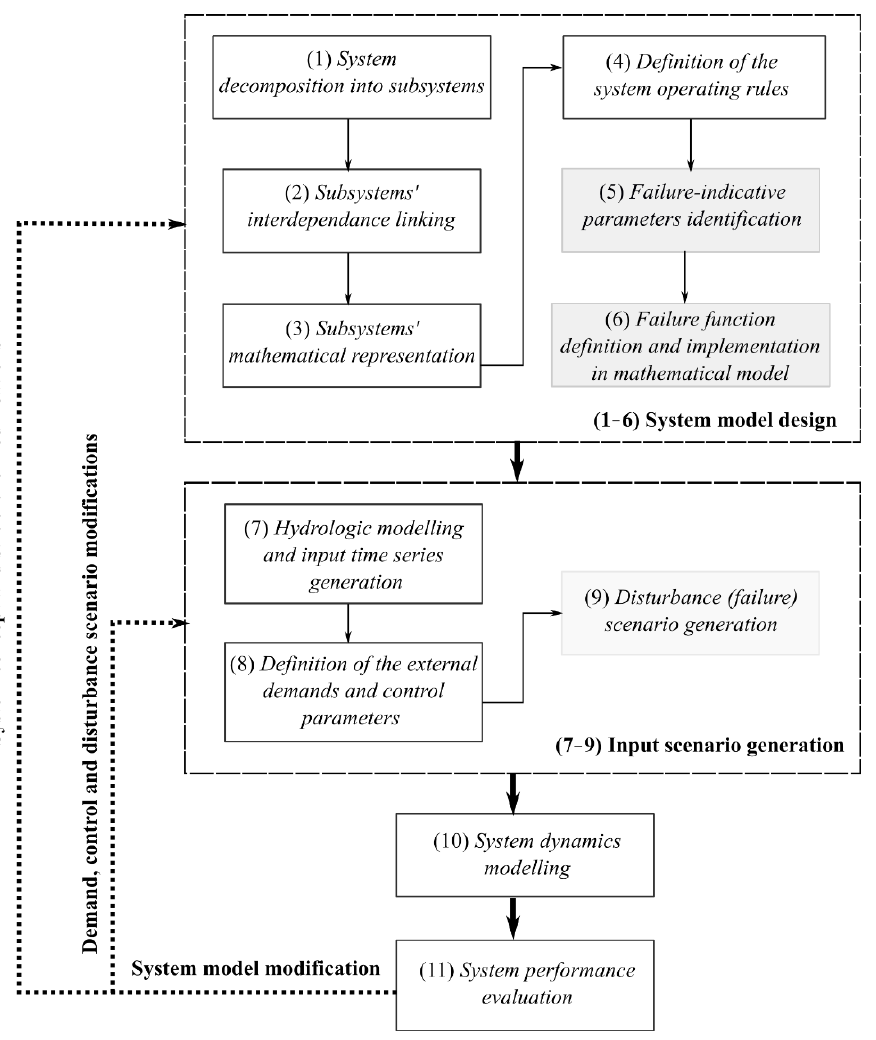
Figure 1. Schematic framework overview.